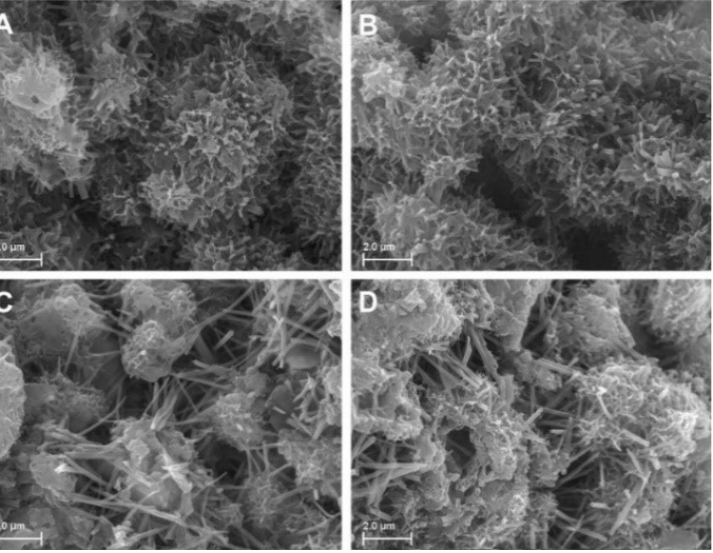
Figure 3. SEM pictures at 24 h: ( A ) reference, ( B ) 20CC, ( C ) 20CC–10µLS, and ( D ) 20CC–3C-S-H [48].